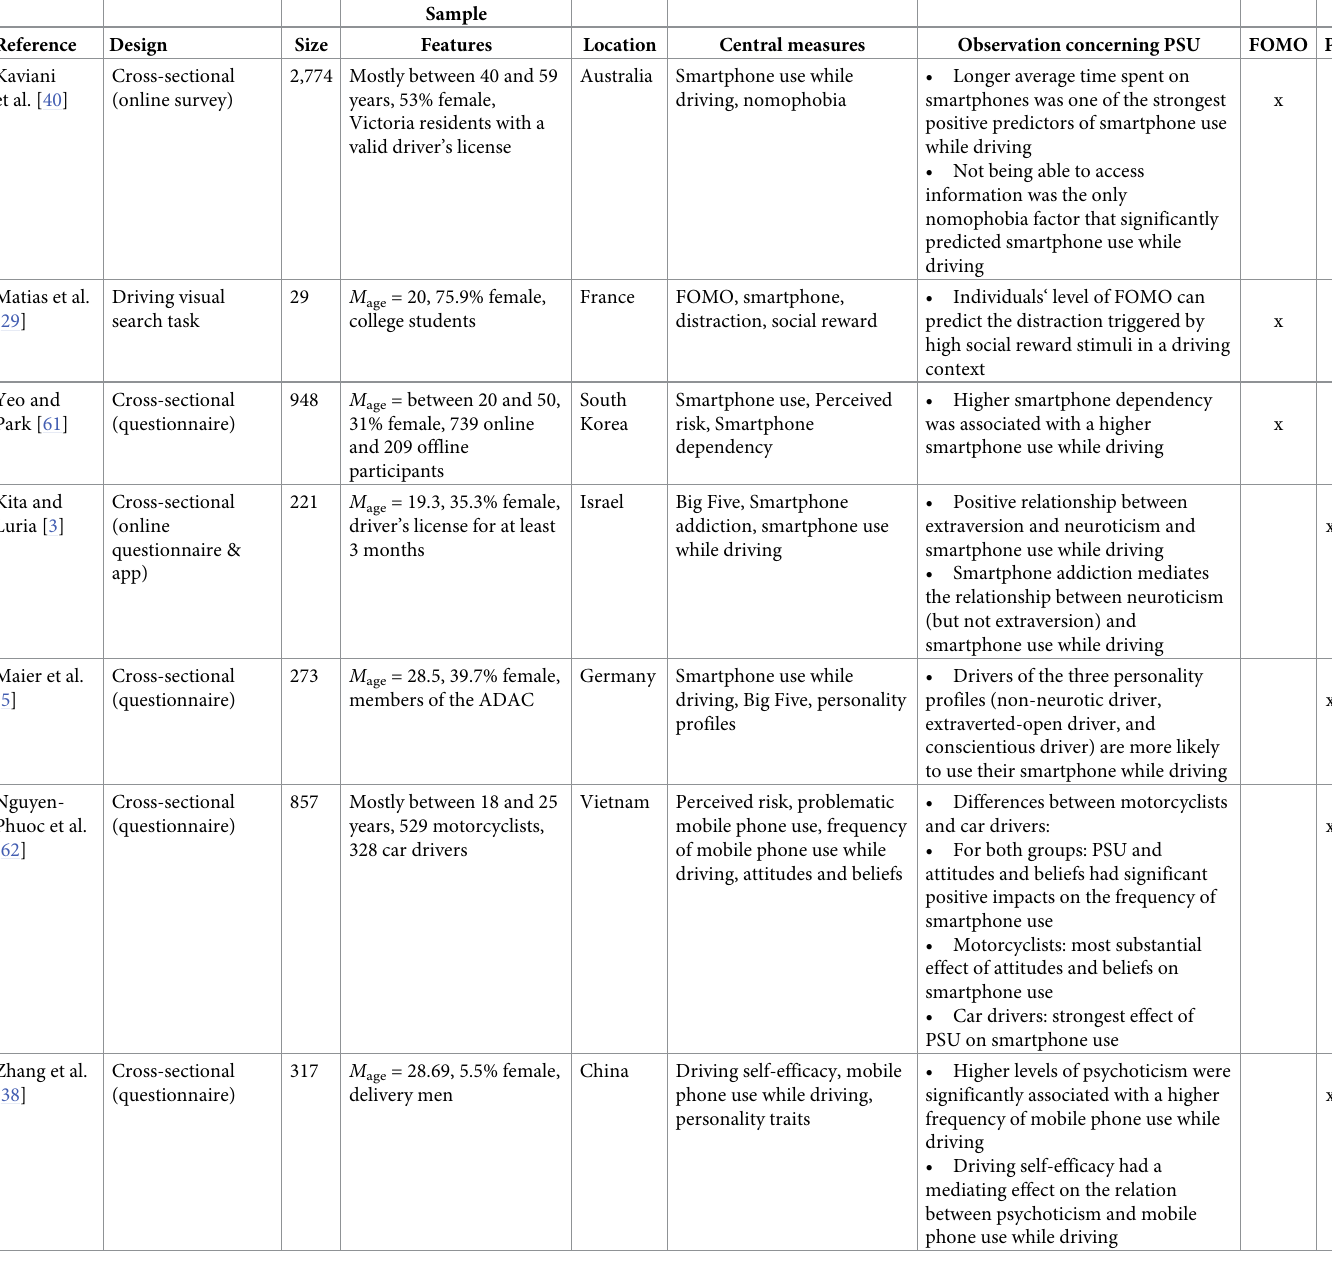
Table 1. Overview of studies investigating the relationship between smartphone use while driving, problematic smartphone use, fear of missing out, and personality